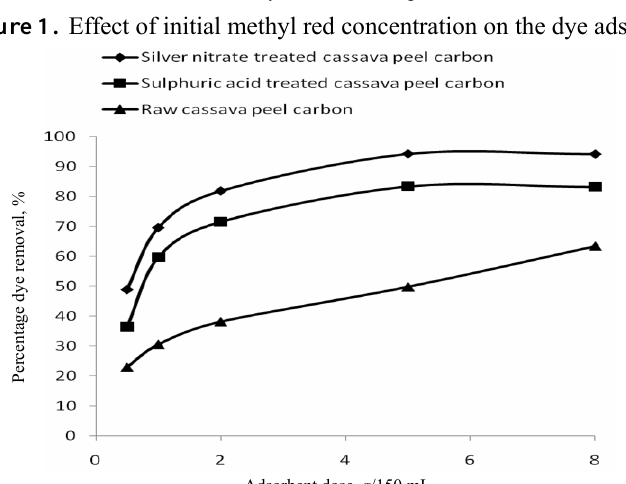
Figure 2. Effect of adsorbent dose on the dye